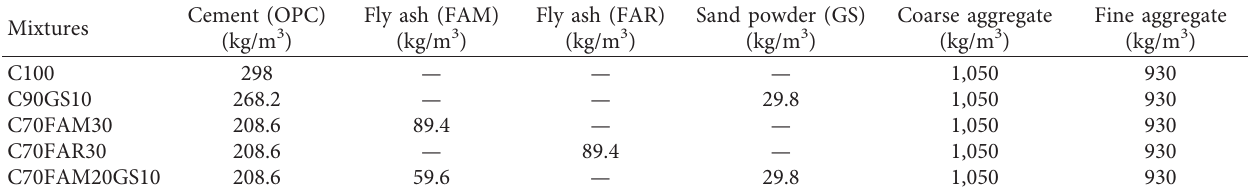
Table 7: Mix proportions of concrete that are used to compare the unit price.